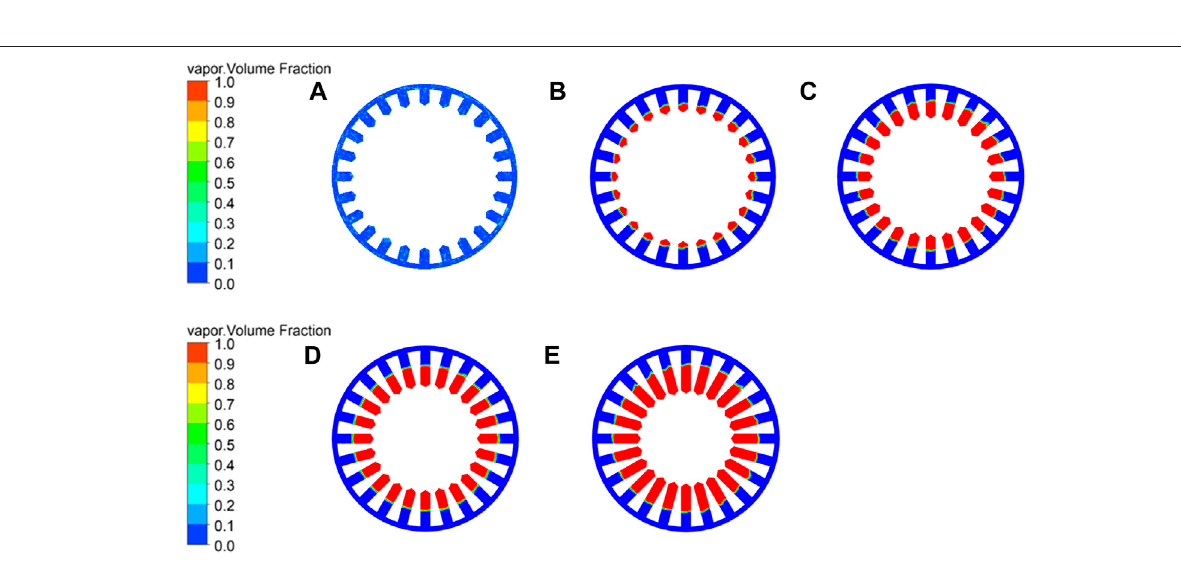
Frontiers in Energy Research |